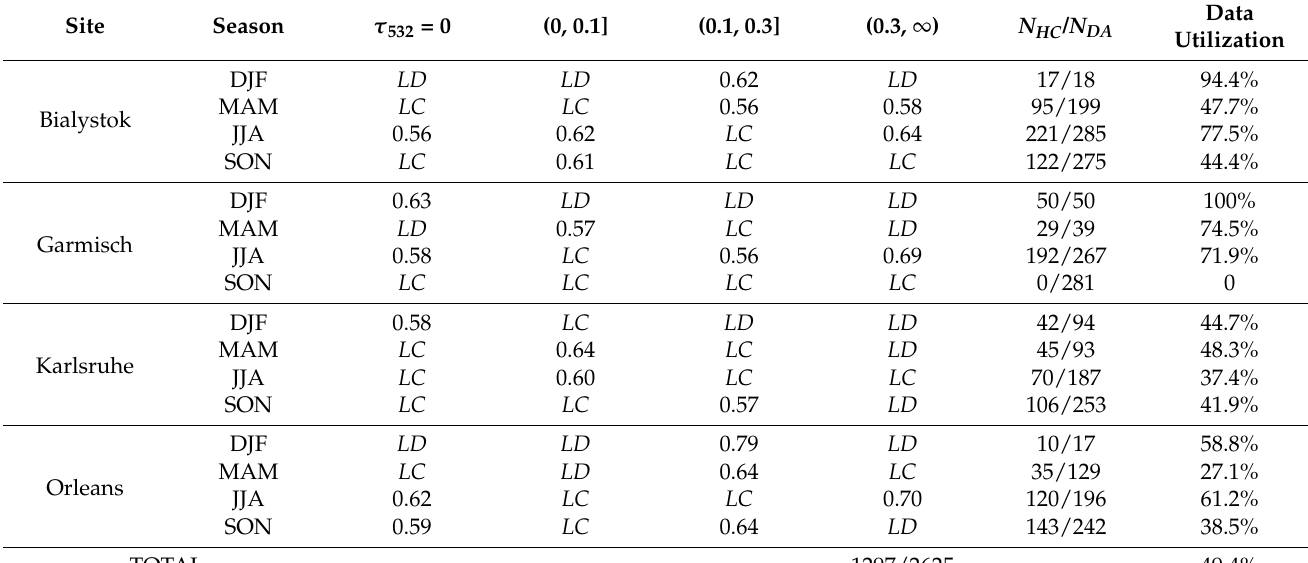
Table 5. The correlation coefficients between HGMS’s XCO 2 bias and AOD ratio at different seasons, different τ 532 , and different TCCON Sites. LD means lack of data. LC means low